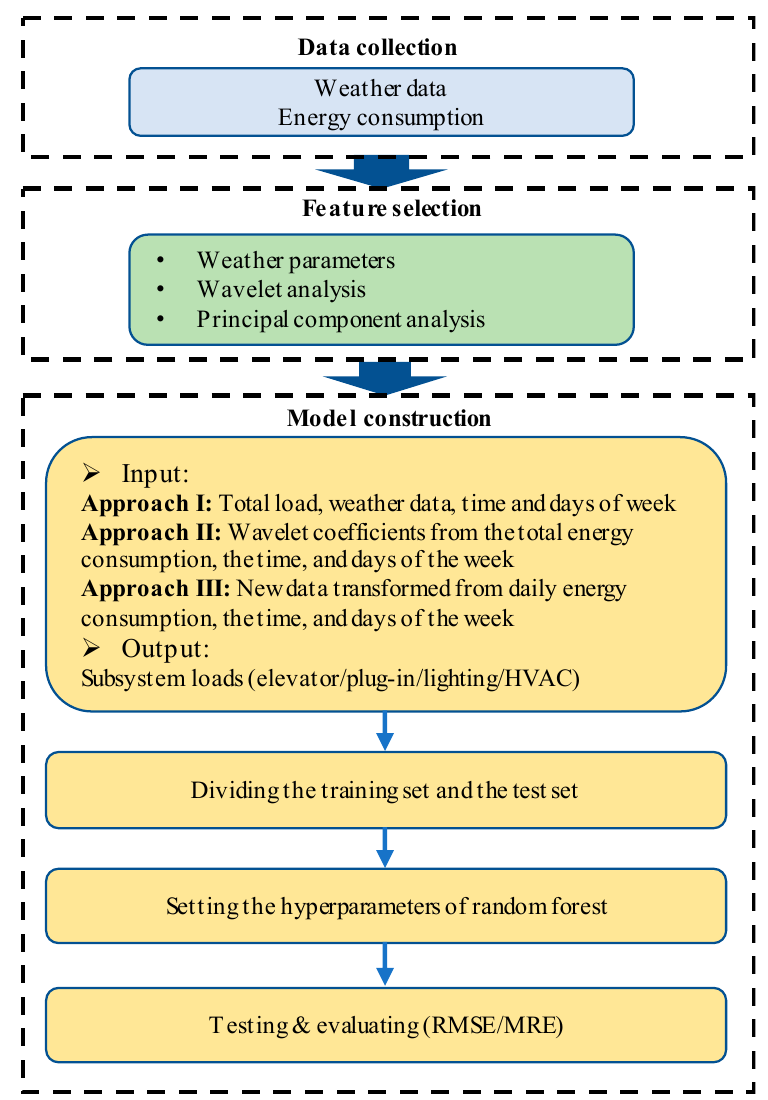
Figure 1. The framework of the NIM method based on RF.